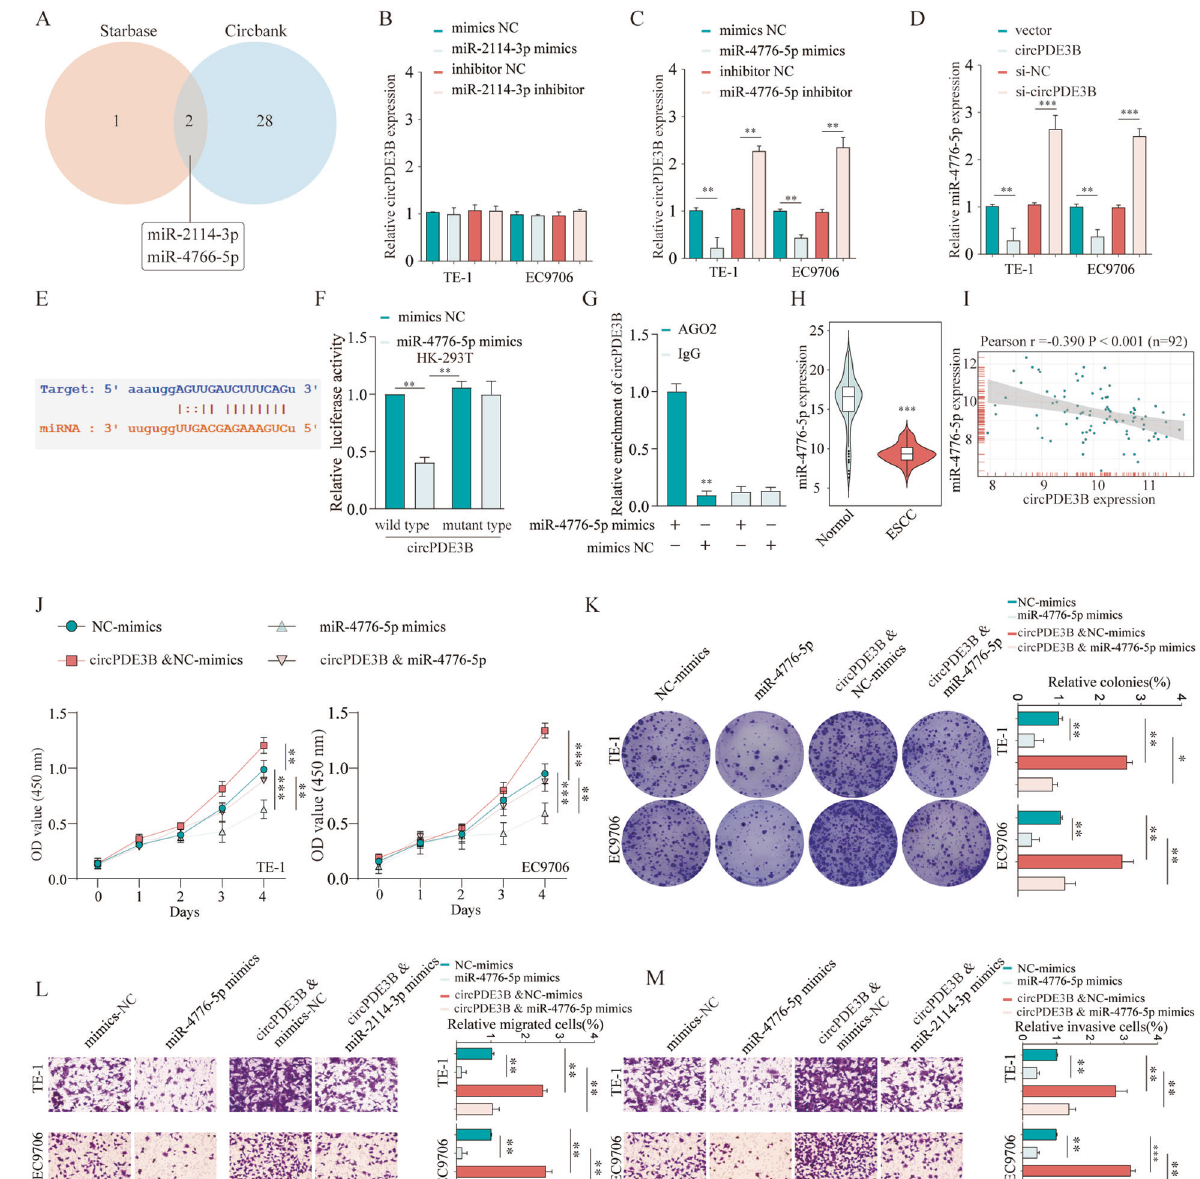
Fig. 5 circPDE3B exerts its oncogenic function by sponging miR-4766-5p. A The intersection of miRNAs targeting circPDE3B predicted by Circbank and Starbase is shown via the Venn diagram. B , C The relative expression of circPDE3B in TE-1 or EC9706 cells after transfected miR- 2114-3p or miR-4766-5p was analyzed by qRT-PCR, respectively. D The relative expression of miR-4766-5p in TE-1 or EC9706 cells after circPDE3B knocking down or overexpression was analyzed by qRT-PCR, respectively. E Schematic of the predicted binding site between miR- 4766-5p and circPDE3B sequence. F Cells were transfected with a luciferase reporter plasmid containing wide-type circPDE3B or mutant-type circPDE3B, together with or without miR-4766-5p. The relative luciferase activity was analyzed. G Immunoprecipitation of AGO2 (control, anti- IgG) in miR-4766-5p mimics or mimics control transfected ES9706 cells were performed. H Expression levels of miR-4766-5p in 92 paired ESCC specimens and the corresponding paired normal adjacent tissues. I Correlation analysis of circPDE3B and miR-4766-5p in ESCC patients ’ tissues. J CCK-8 assays were used to detect cell viability of TE-1 and EC9706 cells after indicated transfection. K Colony formation assays were used to detect the clone ability of TE-1 and EC9706 cells after indicated transfection. Transwell assays were used to detect cell migration ( L ) and invasion ( M ) capacities of TE-1 and EC9706 cells after indicated transfection. * p < 0.05, ** p < 0.01, *** p < 0.001.